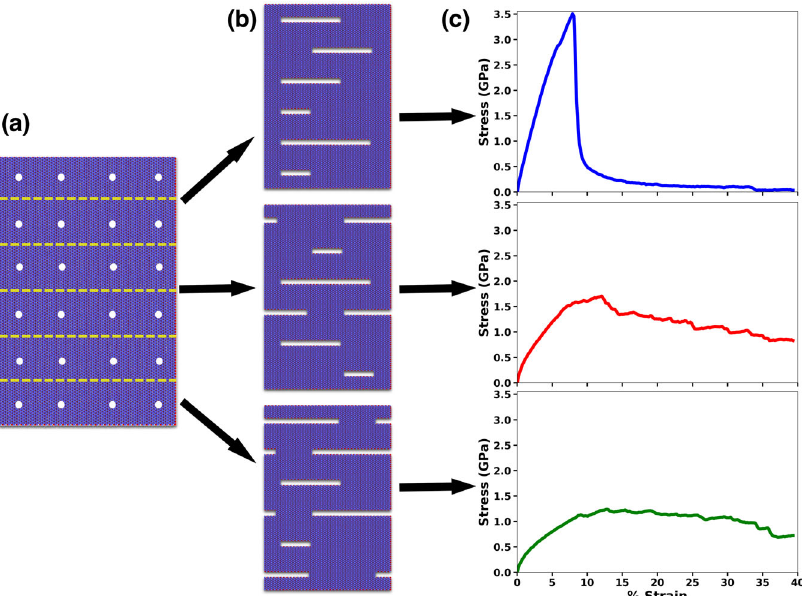
Fig. 1 MD simulation of MoS 2 kirigami structures. a Schematic of 20 nm × 30 nm MoS 2 structure showing the vertical partitioning of system into 6 groups (yellow dashed lines) for the synthesis of kirigami structures. In each row, a cut can be placed at one of the four locations (white circle). b Three kirigami structures created by different choices of cut length and location and c their corresponding stress – strain curves by uniaxial tensile deformation simulation using molecular